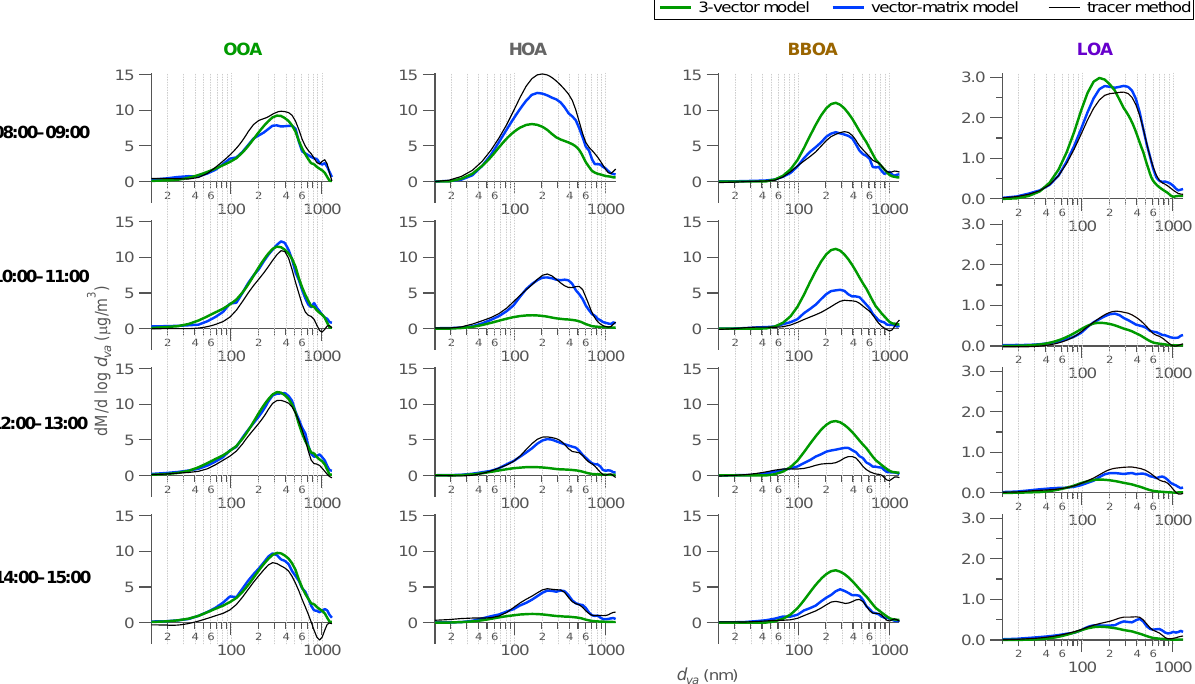
Fig. 11. Comparison of average size distributions as calculated from the 3-vector model, vector-matrix model, and tracer method for OOA, HOA, BBOA, and LOA. The evolution of the size distribution of one aerosol type over all days from 08:00–14:00LT is shown in each column. The size distribution of each aerosol type at the same time is shown in each row. Tracers for each species are estimated from characteristic m/z ’s as described in the